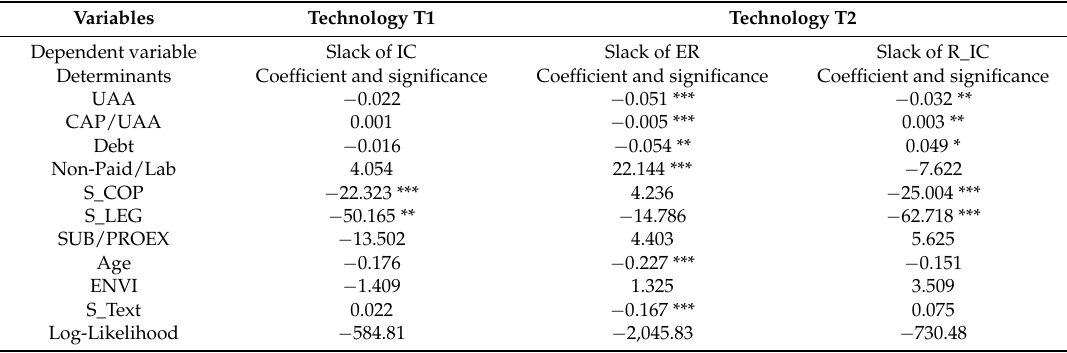
Table 10. Determinants of input slacks for cereals, oilseed crops and protein seed crops farms.